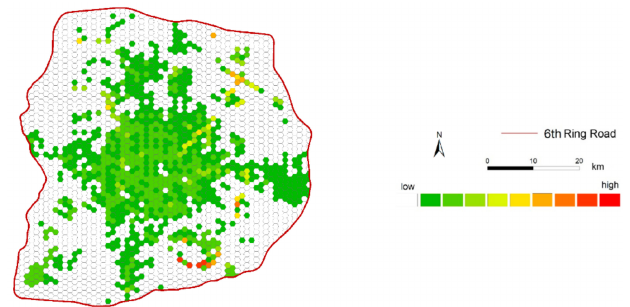
Figure 8. Distribution of medical accessibility in the study